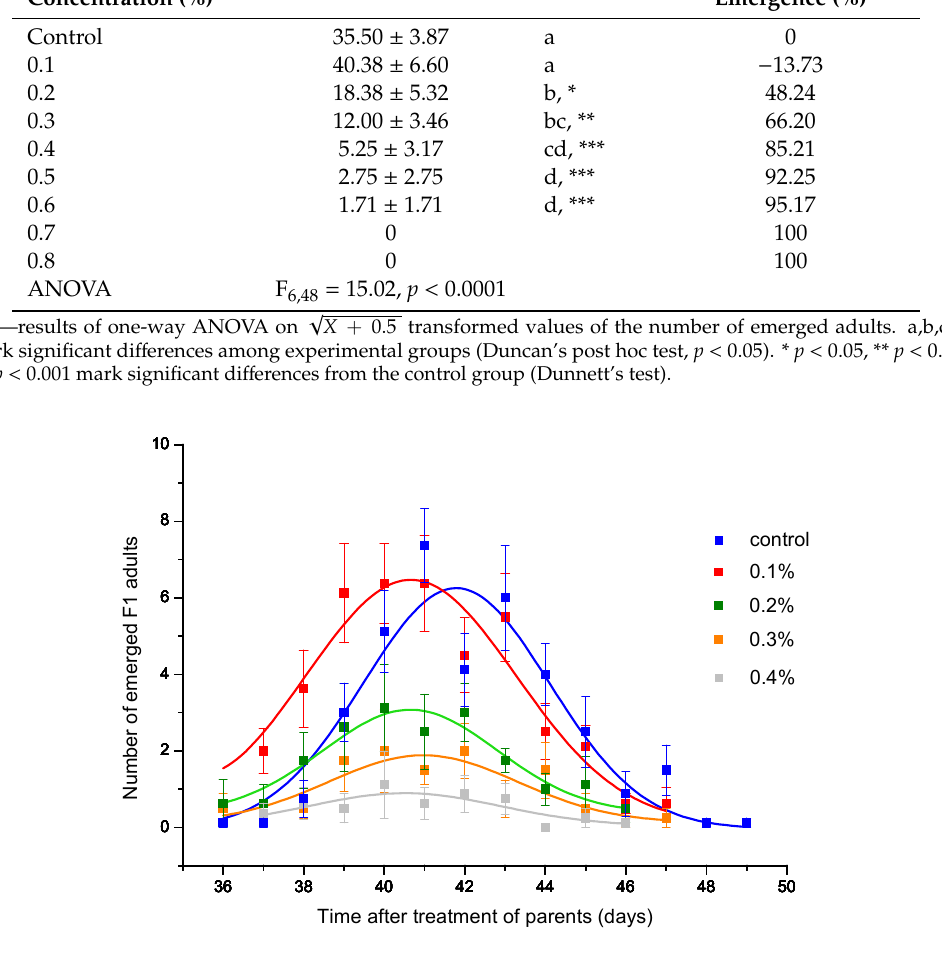
Table 3. Number of emerged Acanthoscelides obtectus adults in F1 generation (means and standard errors for 8 replicates) whose parents were exposed to different concentrations of thyme essential oil (EO).